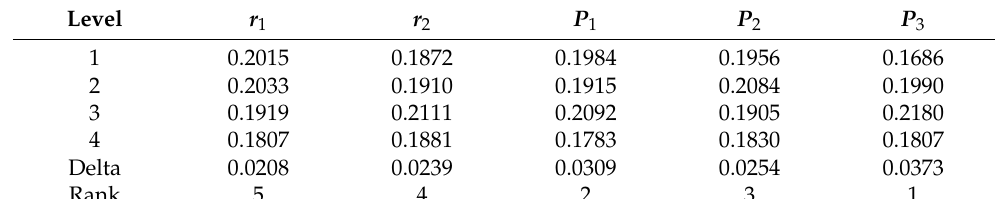
Table 4. Response values and rank of parameters.